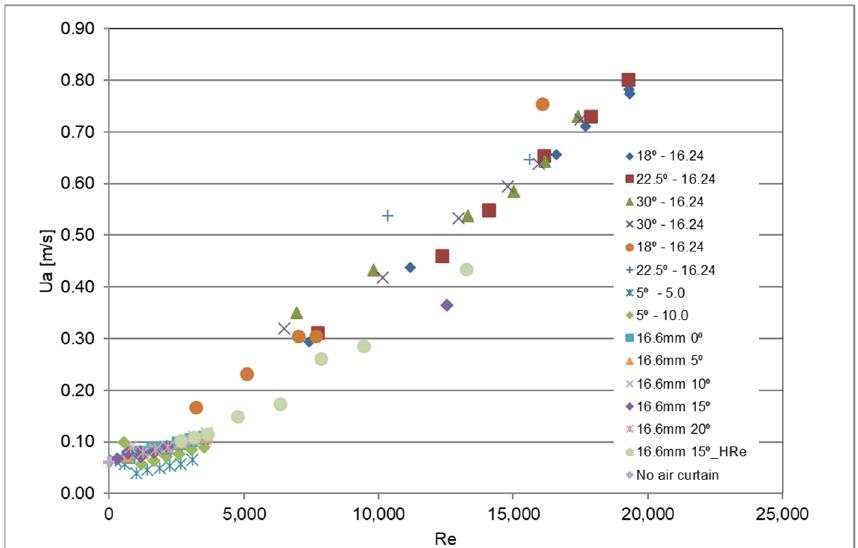
Figure 13. Comparison of test results for visual aerodynamic sealing of the air curtain with the results presented in [27].